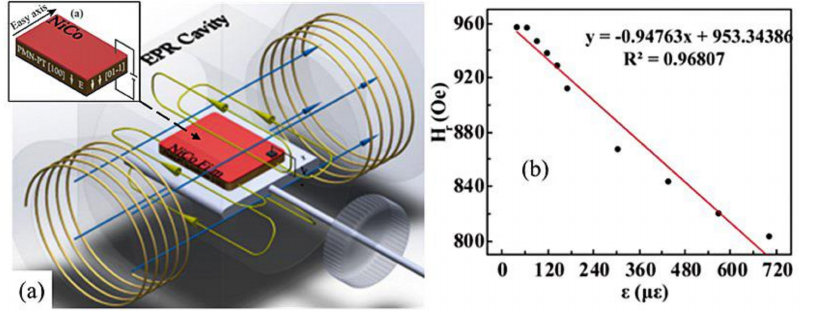
Figure 15. ( a ) the schematic of the EPR cavity and FMR measurement setup; ( b ) the negative correlation between H r and ε of the NiCo film with a static strain range of 0 µε –700 µε by linear fitting